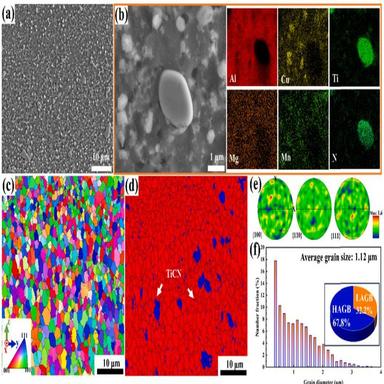
Microstructure of T6 heat treated 2024-5 vol% TiCN composite, (a) low magnification SEM micrograph, (b) high magnification SEM micrograp with corresponding element mappings, and EBSD of 2024 Al alloy matrix: (c) IPF map, (d) matrix grain boundary map, (e) pole figures, and (f) matrix grain size distribution with misorientation angle distribution inset.